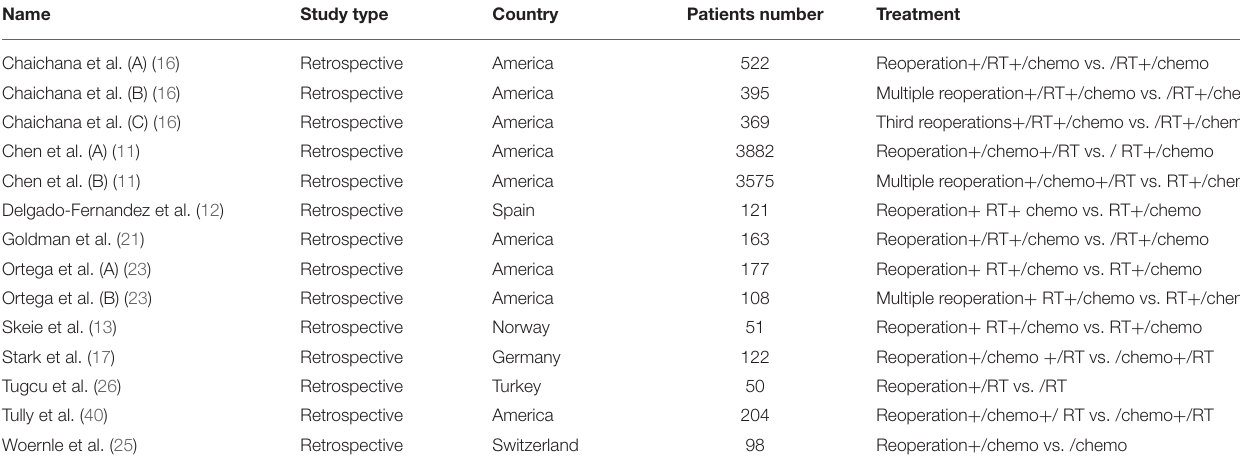
FIGURE 1 | PRISMA flow diagram of study selection. TABLE 1 | Characteristics of included studies for overall survival